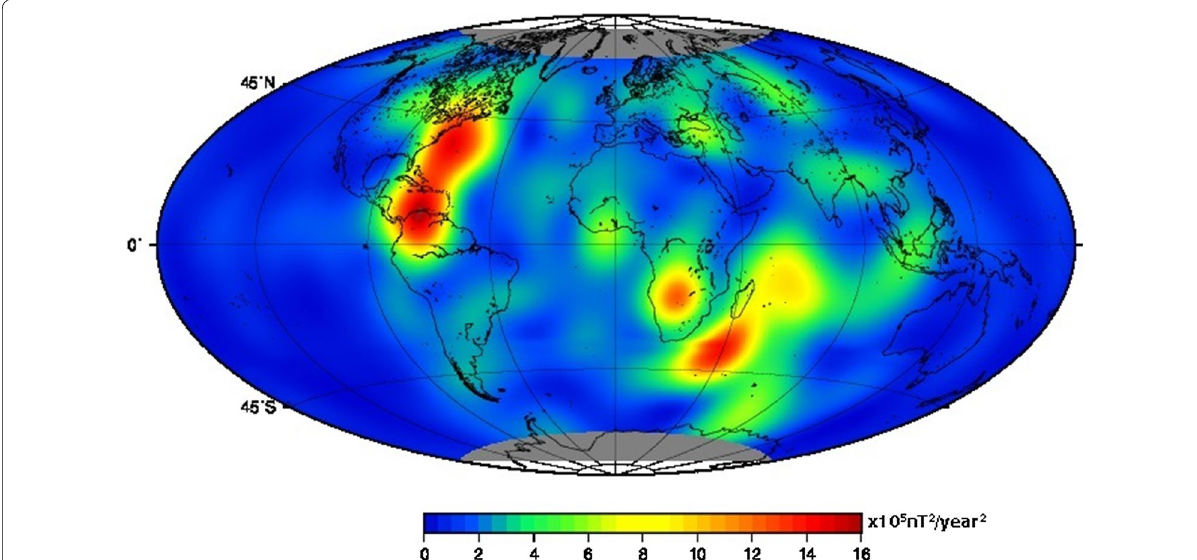
Fig. 7 Geographical distribution of the time-averaged energy of the secular variation of the radial field of the sub-centennial constituent, at the CMB, during the time interval